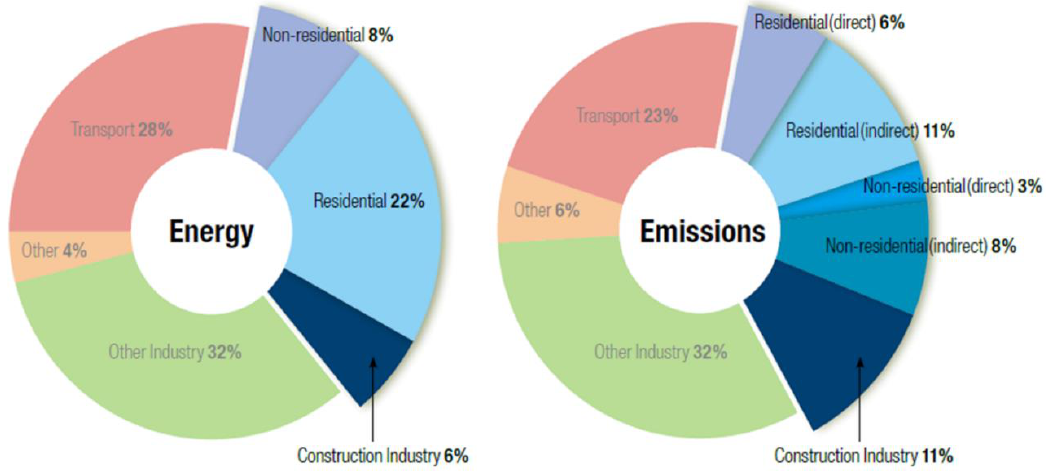
Figure 2. Global share of buildings and construction final energy and emissions, 2018 [6].